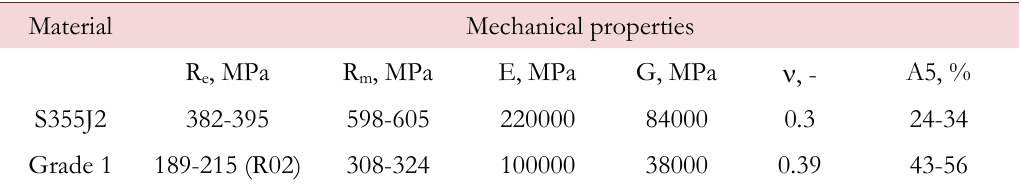
Table 1: Mechanical properties of steel S355J2 and titanium Grade